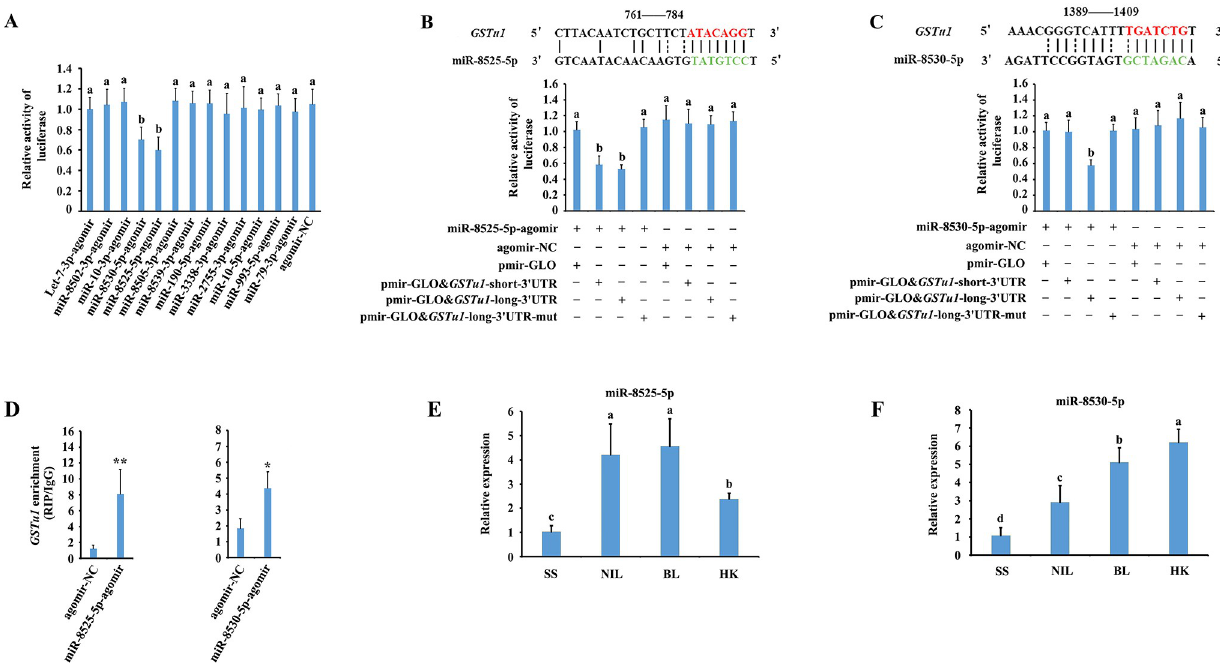
Fig 5. Identification of miRNAs targeting GSTu1 . A: Validation of the interactions of 13 predicted miRNAs with GSTu1 by dual-luciferase reporter assays. Dual-luciferase reporter assays through co-transfection of miR-8525-5p agomir (B) or miR-8530-5p agomir (C) with recombinant pmirGLO vectors containing either wild-type or mutated (mut) binding sites. D: Interactions between miR-8525-5p or miR-8530-5p and GSTu1 determined by RNA-binding protein immunoprecipitation (RIP) in vivo . E: The relative expression of miR-8525-5p (E) and miR-8530-5p (F) in SS, NIL, BL and HK by RT-qPCR. Asterisks indicate significant differences between the treatment and the corresponding control (Student’s t -test, � 0.01 < P < 0.05, �� P < 0.01). Different lowercase letters represent significant differences (one-way ANOVA followed by Tukey’s multiple comparison tests, P < 0.05).